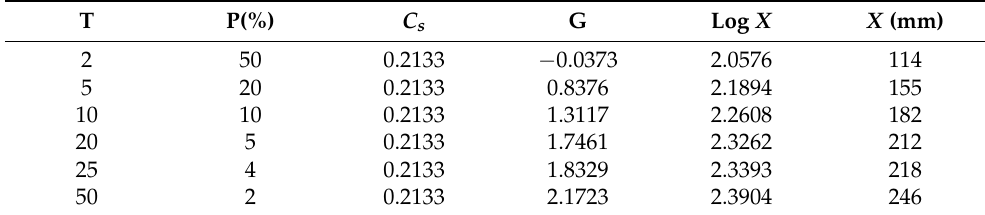
Table 3. Rainfall Design of the Log-Pearson Type